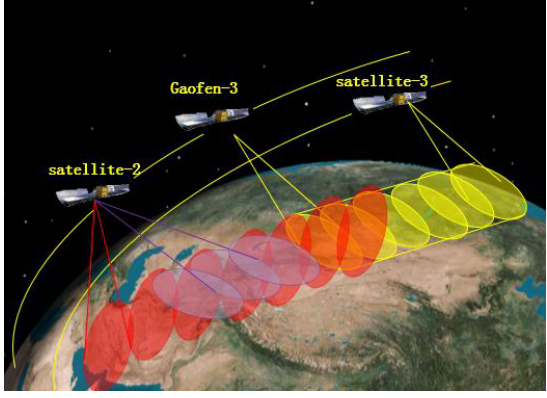
Figure 1. Diagram of the constellation